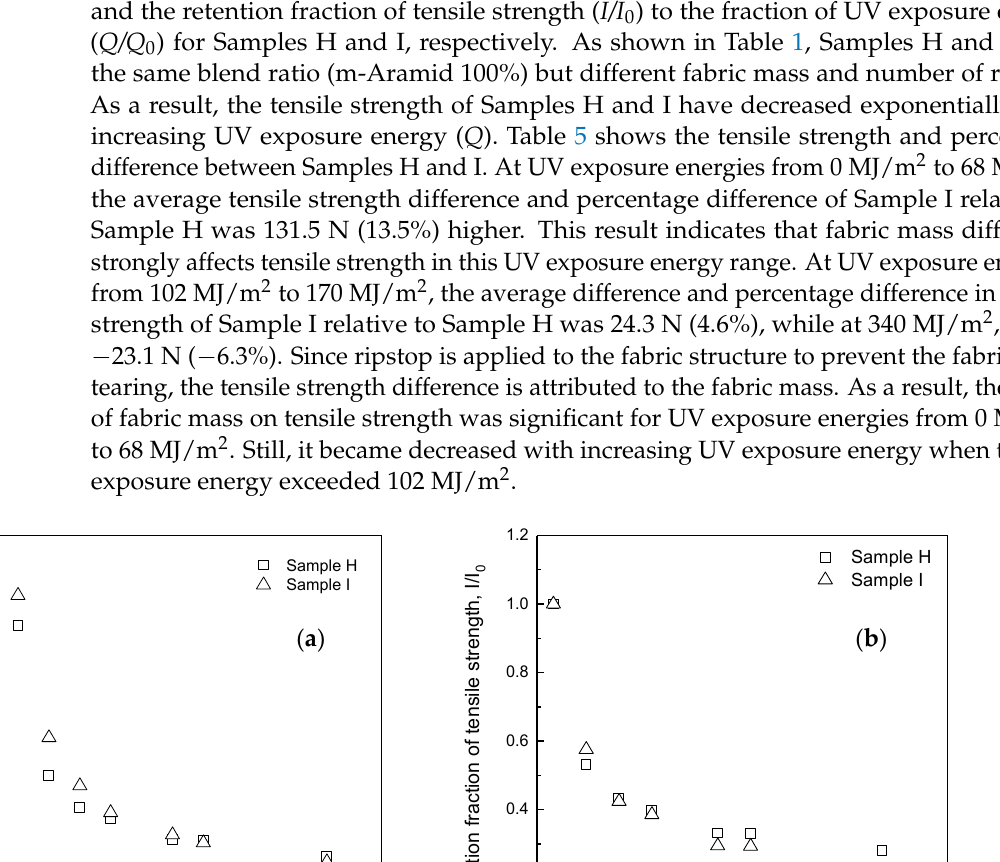
Table 5. Difference of tensile strength affected by mass of fabric (Samples H and I).